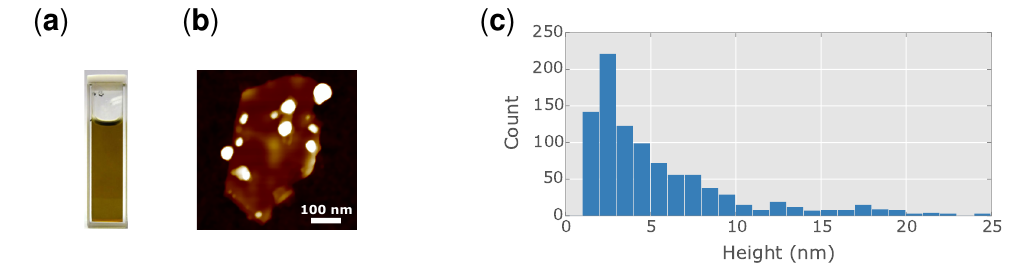
Figure 3. Fabrication of few-layer MoS flakes by liquid-phase exfoliation (LPE), after [32]: 2 ( a ) liquid dispersion of flakes; ( b ) AFM image; ( c ) distribution of flake heights from